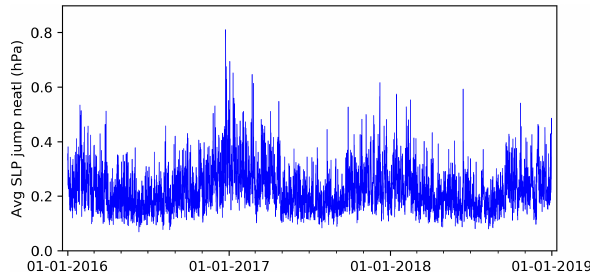
Figure 8. Spatial average over the neatl area (Fig. 5) of ECMWF- IFS absolute pressure jump for each forecast during 2016–2018.